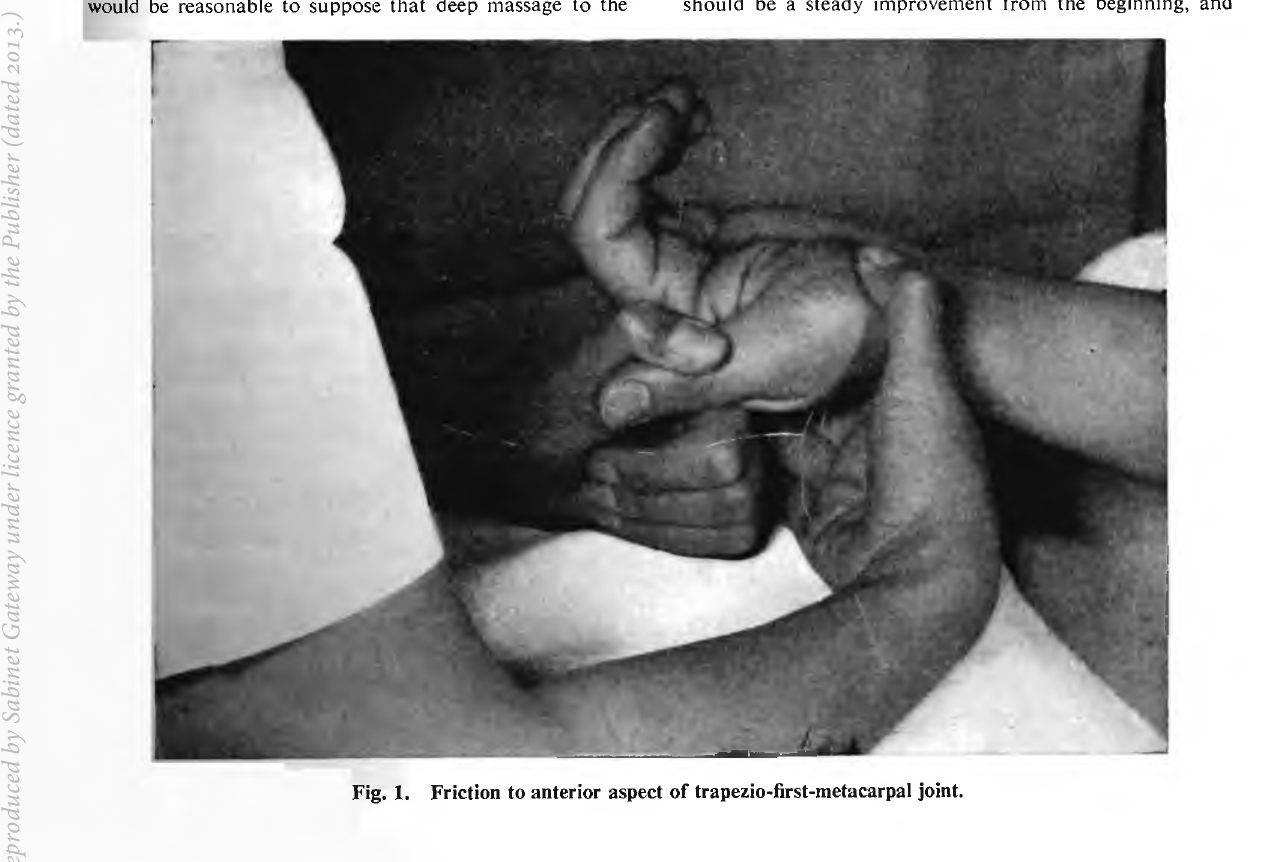
Fig. 1. Friction to anterior aspect of trapezio-first-metacarpal